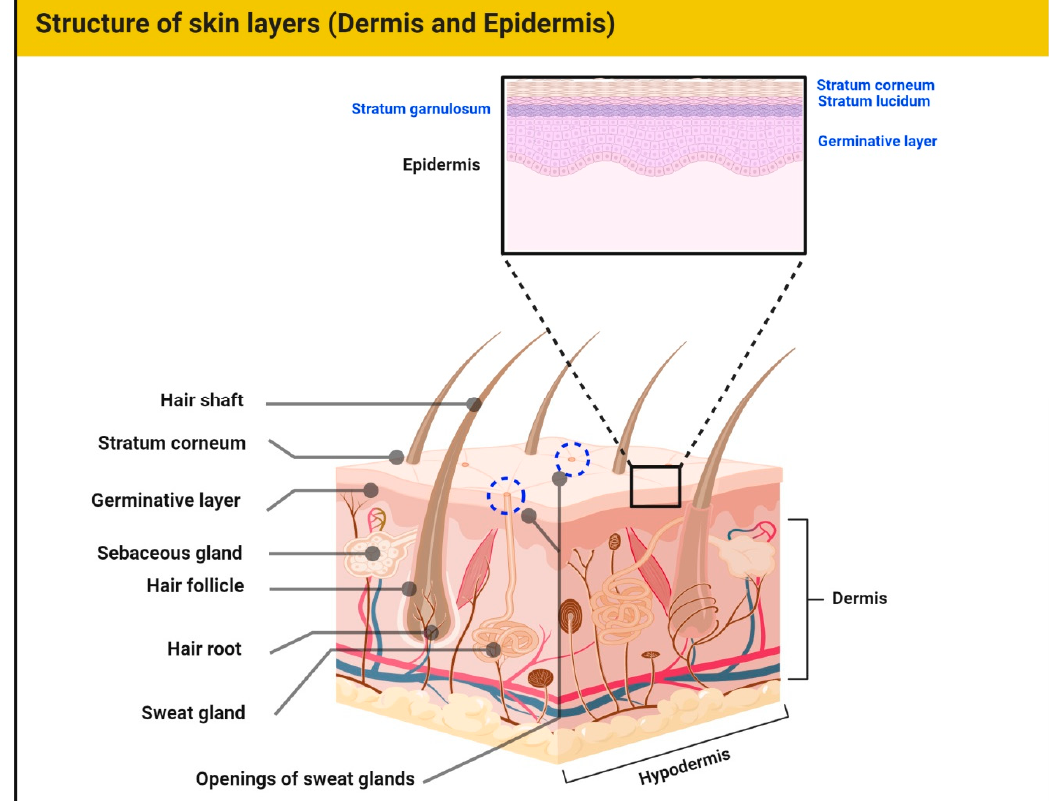
Figure 1. The human skin showing the layers of the epidermis and main structures of the